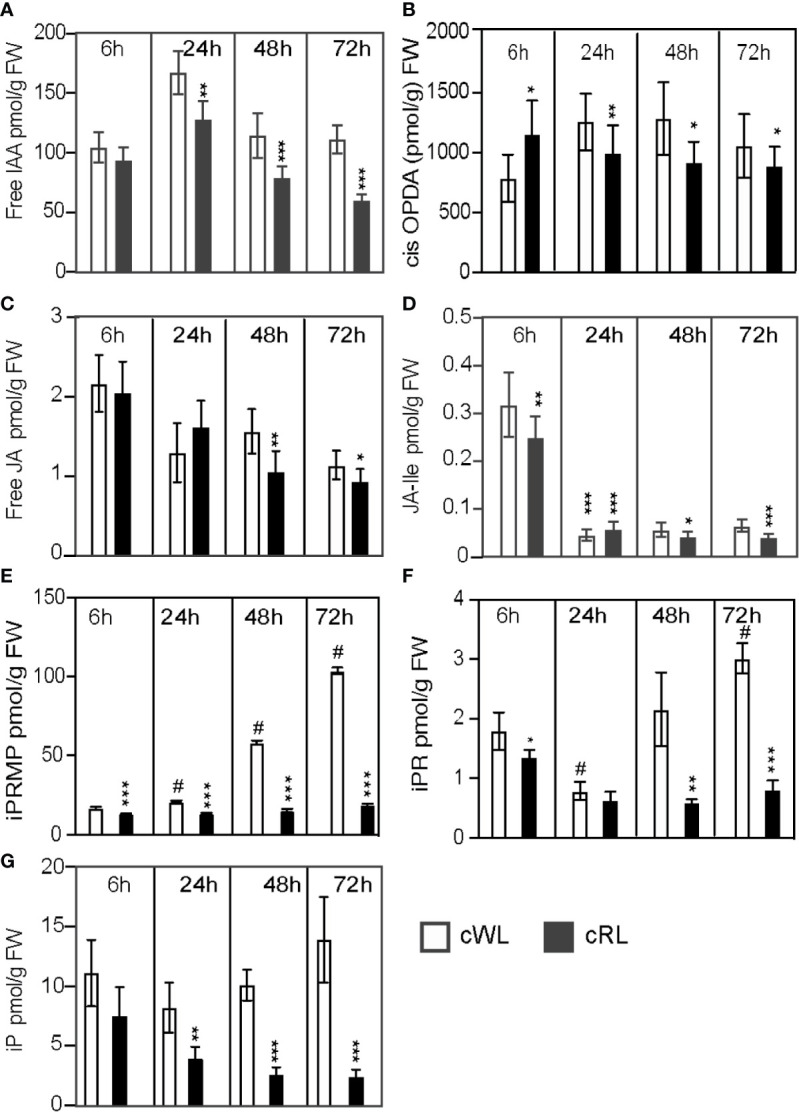
Light spectral quality controls the homeostasis of endogenous contents of different hormones, which positively or negatively affect ARI. (A–G) Three-week-old Norway spruce seedlings were grown under long day conditions as described in Materials and Methods. De-rooted seedlings were then kept in constant cWL or cRL for 6, 24, 48, and 72 h. For each time point in each condition 5 mm hypocotyls were taken and pooled for hormone quantification. Five independent biological replicates were collected for analysis of IAA, and JA contents and additional five independent biological replicates were collected for CKs quantification. (A) free IAA content; (B) free cis-12-oxo-phytodienoic acid (cis-OPDA) content; (C) free jasmonic acid (JA) content; (D) jasmonate-isoleucine (JA-Ile) content; (E) iP riboside 5′-monophosphate (iPRMP) content; (F) iP riboside content (iPR); (G) isopentyl-adenine (iP) content. Values are the means with standard deviation (SD) of 5 biological replicates. Asterisks indicate statistically significant differences under light conditions cRL versus cWL in t-test; *, **, and *** correspond to P-values of (0.05 > p > 0.01, 0.01 > p > 0.001, and p < 0.001 respectively; n = 5); Dash (#) ndicates statistically significant difference at 24 h, 48 h or 72 h versus 6 h in t-test; p < 0.001, n = 5; FW, fresh weight.